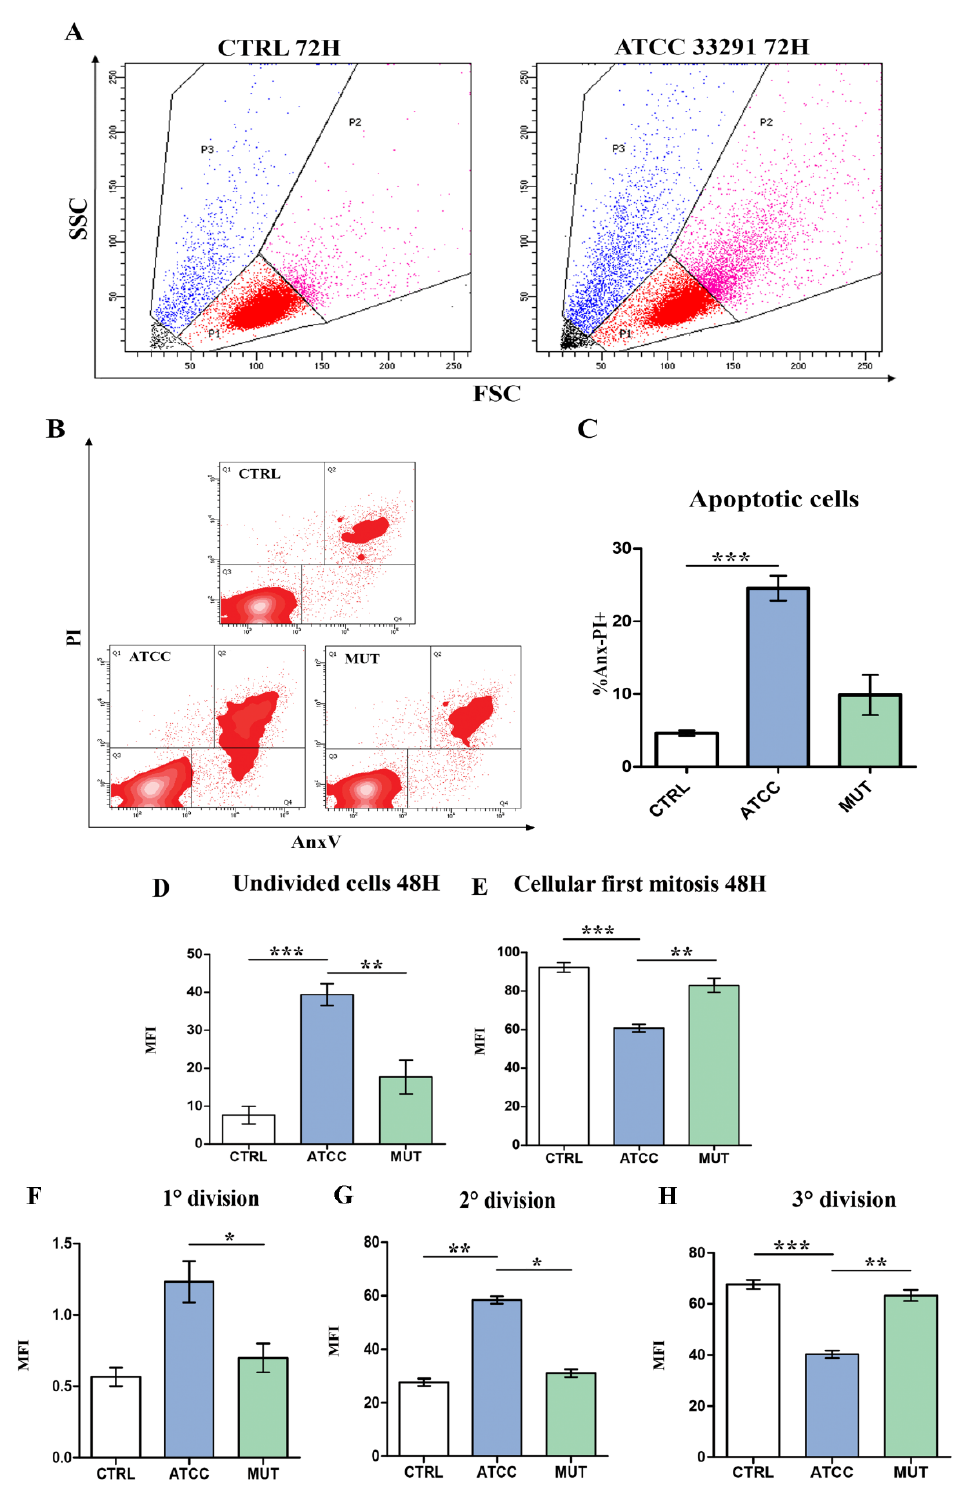
Figure 1. Evaluation of cell death induced by lysates and verification of the e ffi ciency of the toxin, verified only in the ATCC33291-treated cells ( A ) U937 were split into di ff erent sub-populations depending on the morphologic parameters: blue gate shows dead cells, pink gate shows distended cells, and red gate shows viable cells. Total cells were the summary of red, pink, and blue gates. Black represents debris which were excluded for the analysis. Dot plots in the picture show